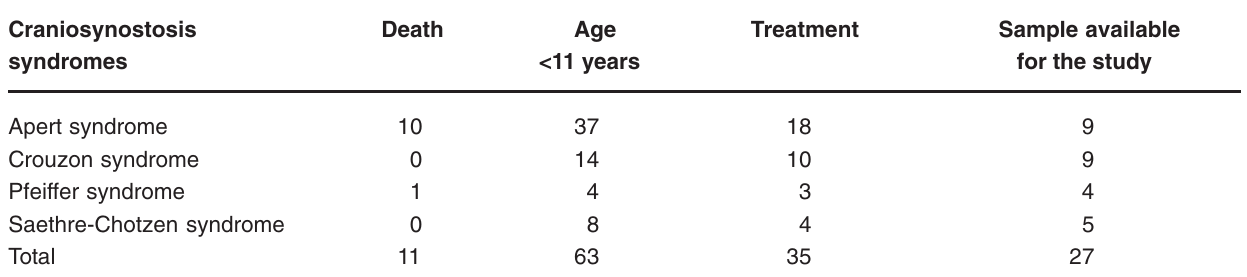
TABLE 1- Entire sample of patients with craniosynostosis syndromes registered at HRAC-USP up to years 2005 and